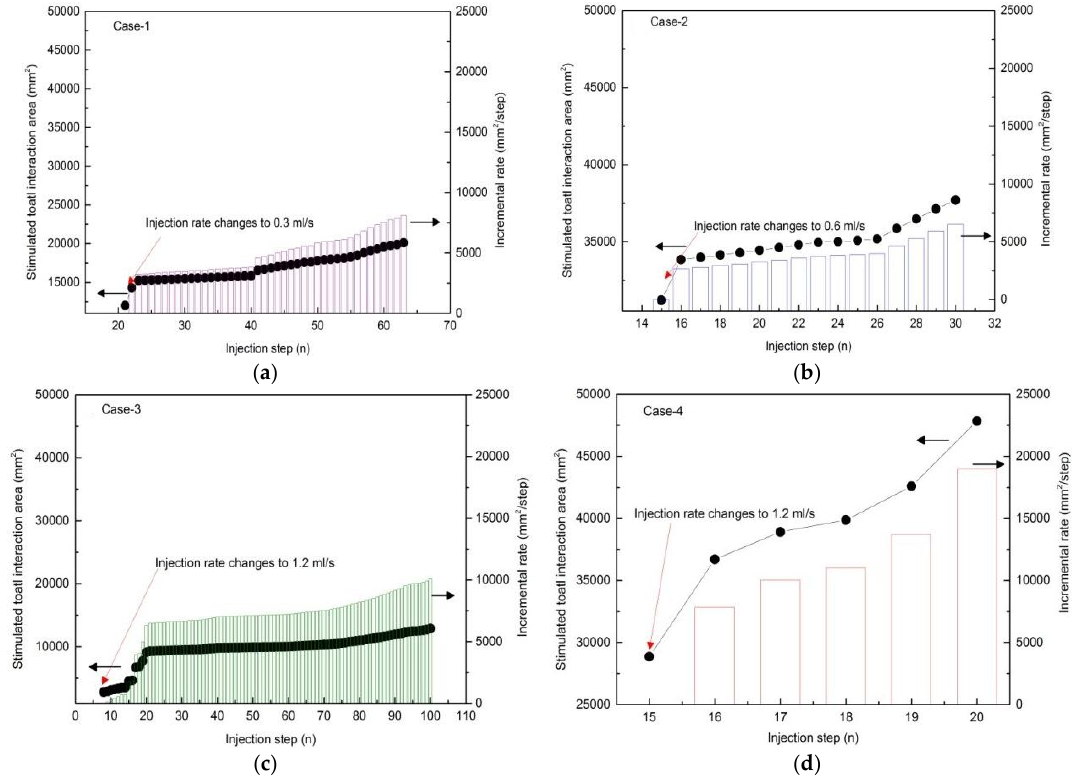
Figure 6. Relationship between stimulated total interaction area and injection step for the four studied cases: ( a ) variation of injection rate is 1.2 mL/s → 0.15 mL/s → 0.6 mL/s → 0.3 mL/s; ( b ) variation of cases: ( a ) variation of injection rate is 1.2 mL/s Ñ 0.15 mL/s Ñ 0.6 mL/s Ñ 0.3 mL/s; ( b ) variation injection rate is 0.6 mL/s → 0.3 mL/s → 1.2 mL/s → 0.15 mL/s; ( c ) variation of injection rate is 1.2 of injection rate is 0.6 mL/s Ñ 0.3 mL/s Ñ 1.2 mL/s Ñ 0.15 mL/s; ( c ) variation of injection rate mL/s → 0.6 mL/s → 0.3 mL/s → 0.15 mL/s; and ( d ) variation of injection rate is 0.15 mL/s → 0.3 mL/s → 0.6 mL/s → 1.2 mL/s).